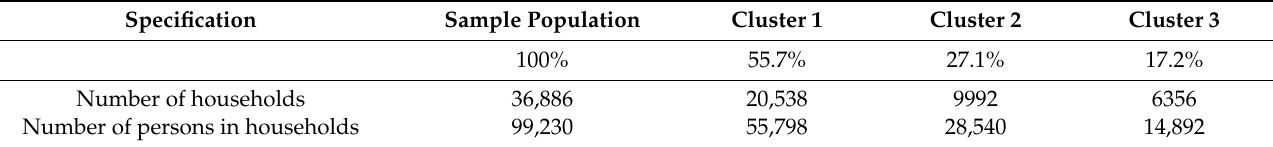
Table 6. Cluster analysis: characteristics of clusters in terms of selected socio-economic